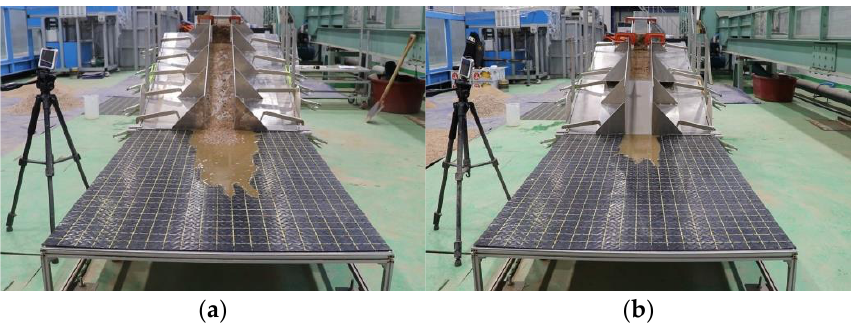
Figure 4. Flow chart of laboratory tests.